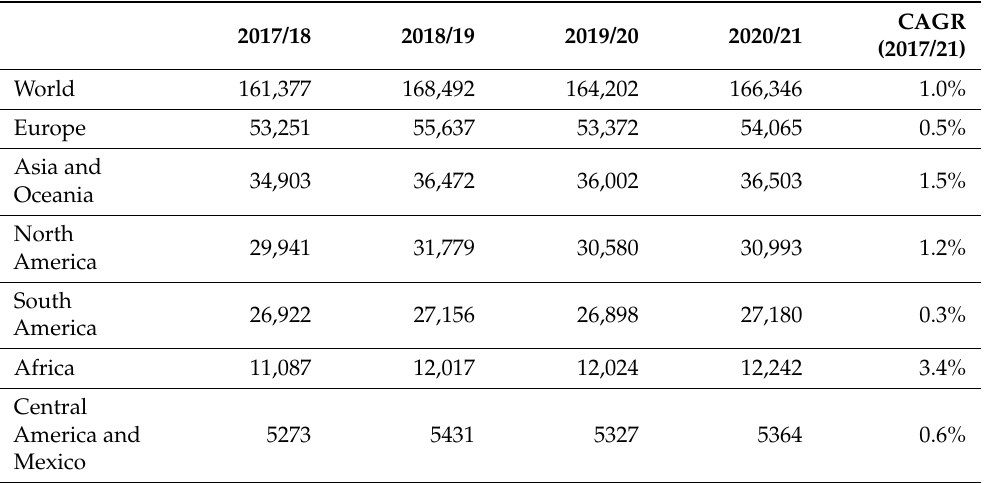
Table 1. World coffee consumption in thousand 60 kg bags. Own elaboration based on literature data